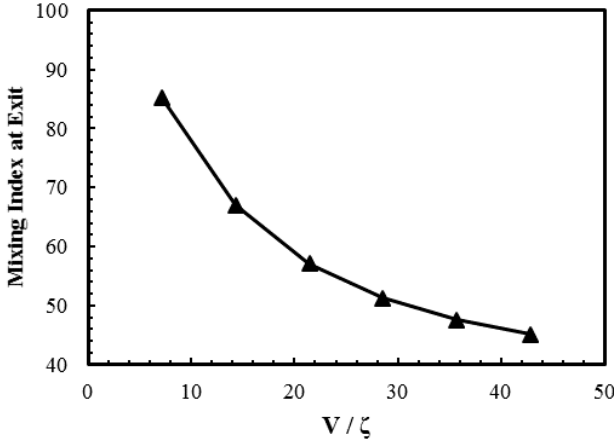
Figure 8. Effect of V / ζ on mixing index at the exit.